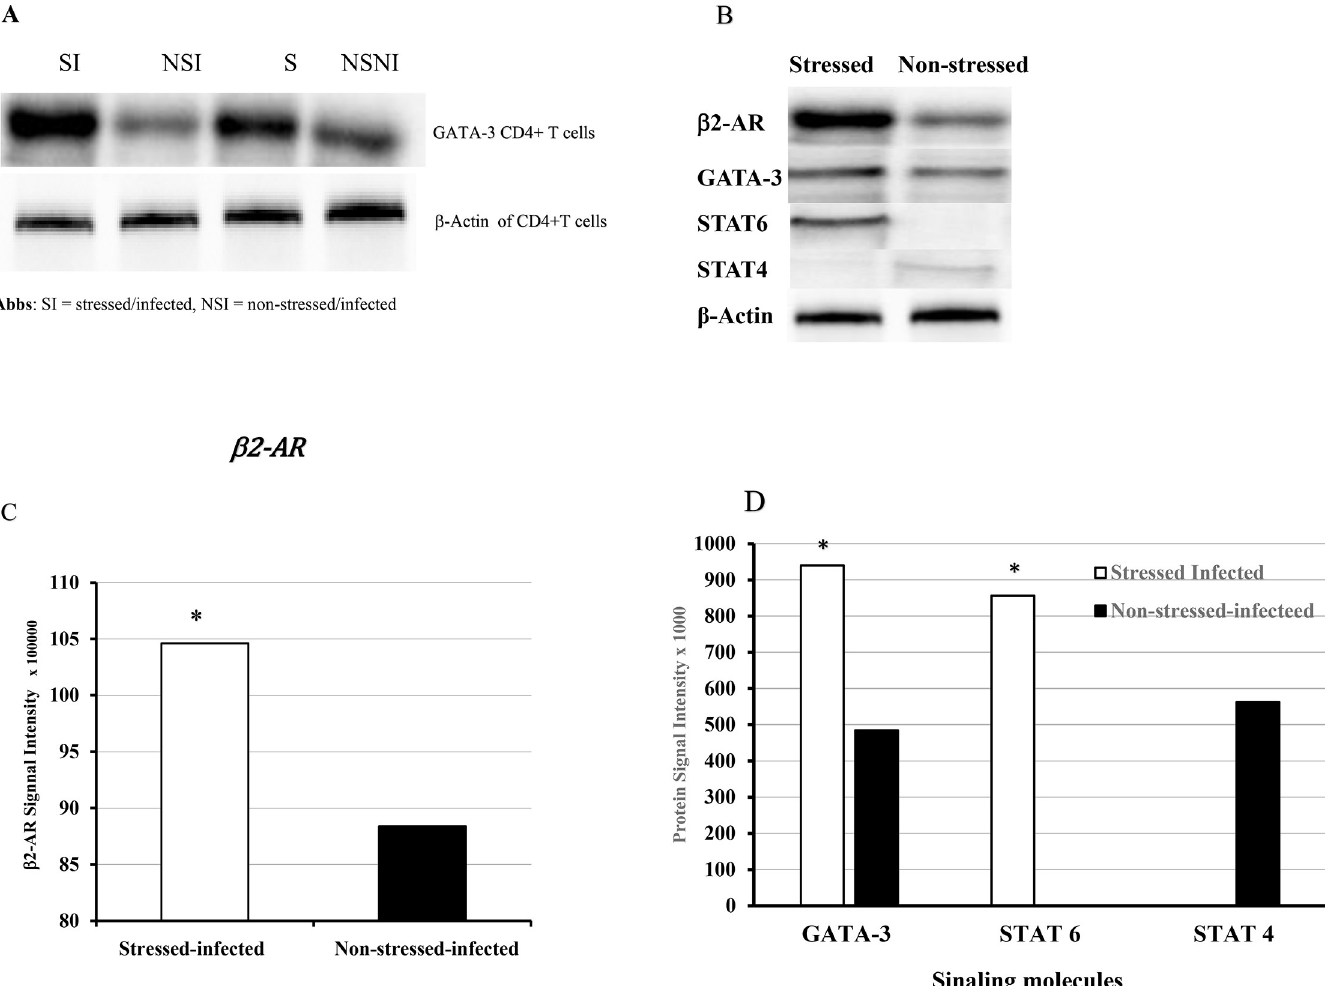
Fig 8. Western blot analysis of Protein expression of A ) GATA-3, B ) β 2-AR, GATA-3, STAT 4 & 6, and β -Actin, C ) β 2-AR intensity, D ) GATA-3, STAT4 and STAT6 intensities in CD4+T cells isolated from the genital tract of stressed and non-stressed mice. Amplified Opti-4CN Substrate Kit from Bio-Rad was used to detect protein concentration following the manufacturer’s instructions. Relative protein expression was calculated as described in materials and methods. Data shown are a representative of two or more independent experiments performed on different dates.